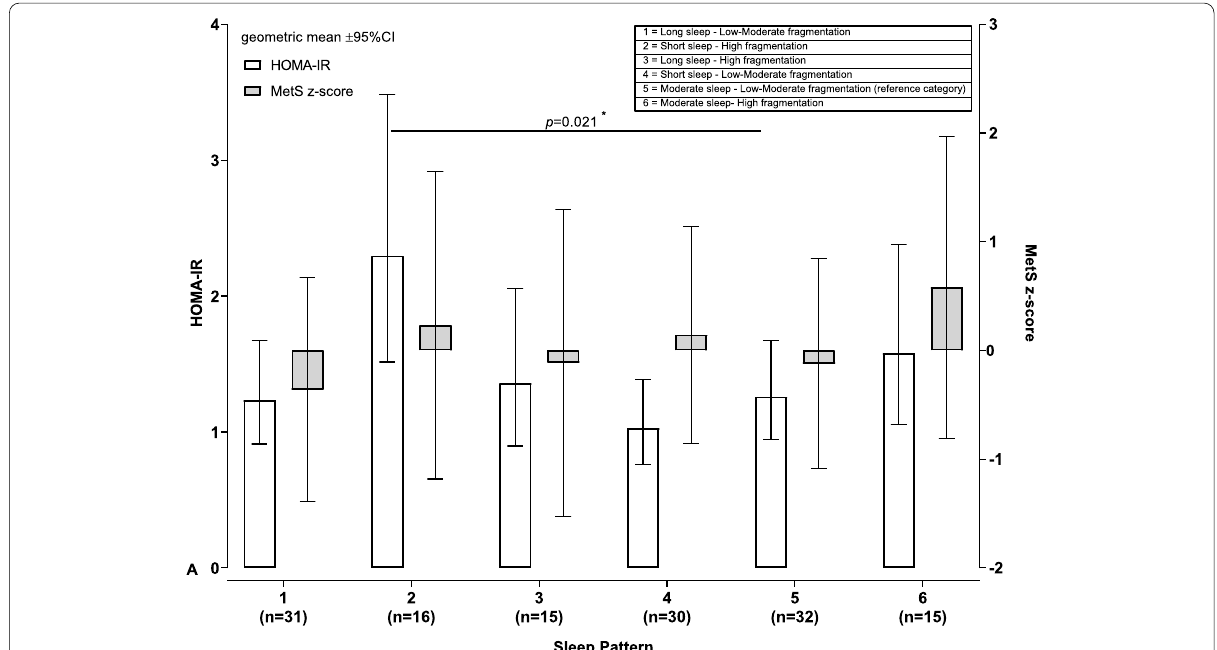
Fig. 1 Cardiometabolic profiles across categories of accelerometry-derived sleep patterns. Cardiometabolic profile across sleep time and sleep fragmentation patterns (HOMA-IR [ p < 0.0001, adjusted R 2 0.2393]: age, sex, Conicity Index, socio-economic status, fruit and vegetable intake, = sugar-sweetened beverages, alcohol and tobacco usage, Vector Magnitude, HIV status; MetS z-score [ p 0.4538, adjusted R 2 0.0009]: age, sex, = = socio-economic status, fruit and vegetable intake, sugar-sweetened beverages, alcohol and tobacco usage, Vector Magnitude, HIV status). Sleep Pattern versus Sex interaction: p 0.5702. The horizontal lines between the sleep pattern categories indicate significant post hoc differences ≥ between categories at either end of the line. * Comparison with reference category (Moderate Sleep – Low-moderate